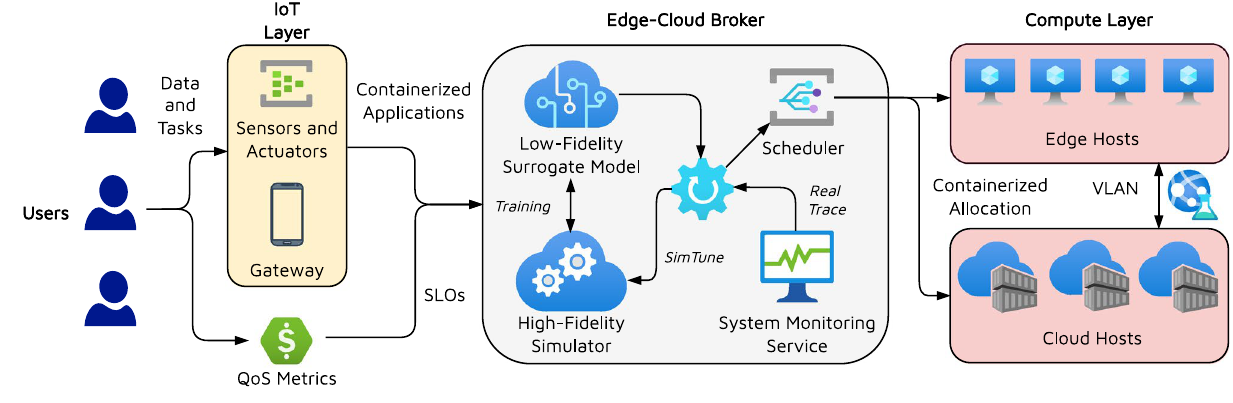
Figure 1. System